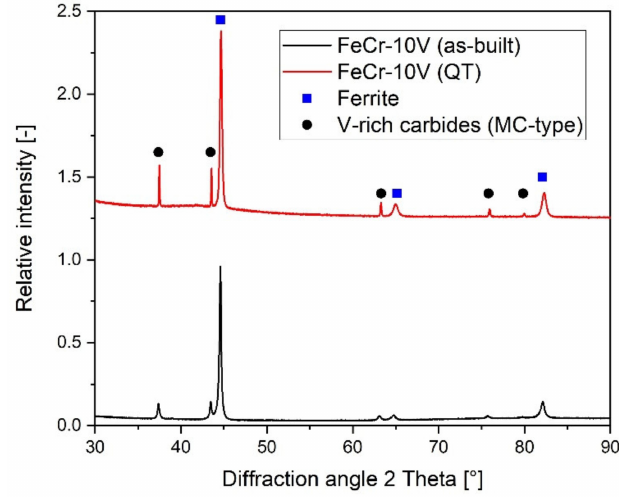
Figure 8. XRD measurements of as-built and heat-treated (QT) FeCr-10V cutting crowns with phases being detected as ferrite (alpha) and fcc (V-rich